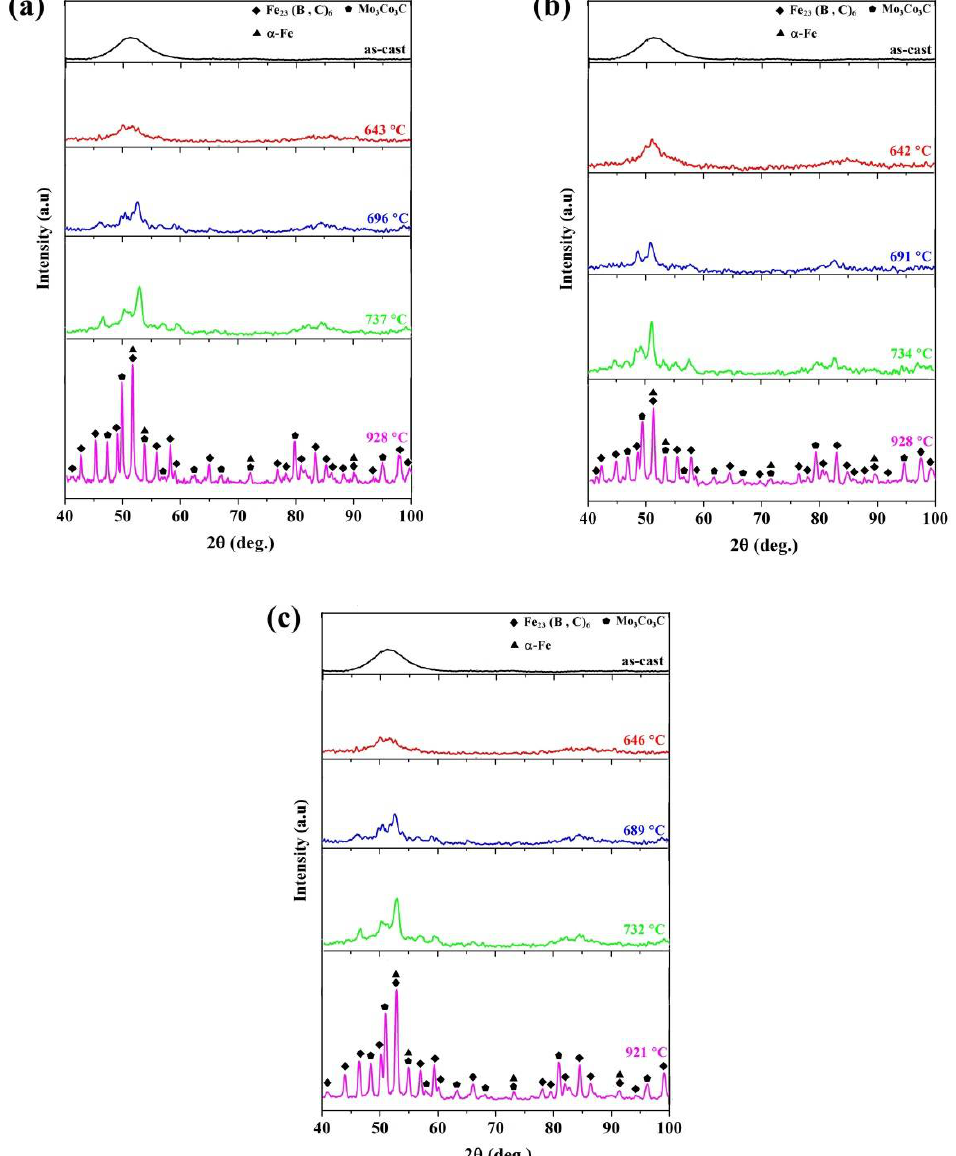
Figure 2. XRD patterns of the as-cast (Fe 41 Co 7 Cr 15 Mo 14 Y 2 C 15 B 6 ) 100−x Cu x (x = 0, 0.25 and 0.5 at.%) BMGs and the annealed specimens up to the maximum temperature of each peak. ( a ) x = 0 at.%; ( b ) x = 0.25 at.%; ( c ) x = 0.5 at.%.